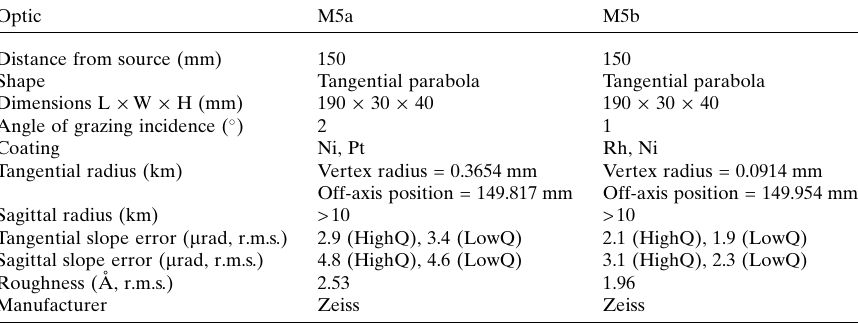
Table 2 Specification of M5 collecting mirrors after the sample